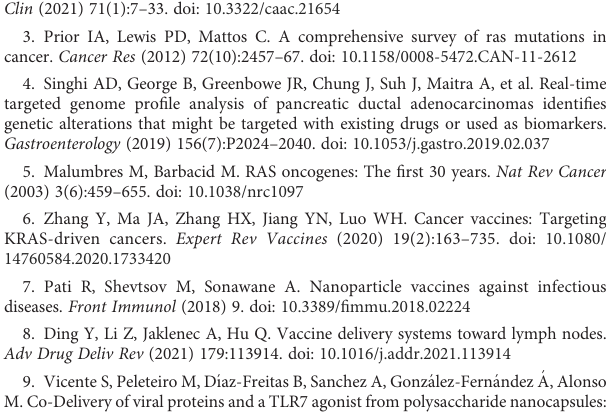
SUPPLEMENTARY TABLE 2 Summary of the times and volumes used for each reagent for the different coagulation tests. SUPPLEMENTARY TABLE 3 List of antibodies used in fl ow cytometry - macrophage polarization. SUPPLEMENTARY TABLE 4 List of antibodies and reagents used in fl ow cytometry – splenocytes and tumor analysis. SUPPLEMENTARY TABLE 5 Physico-chemical characterization of nanocapsules of INU/pArg in the absence and presence of mutated antigenic